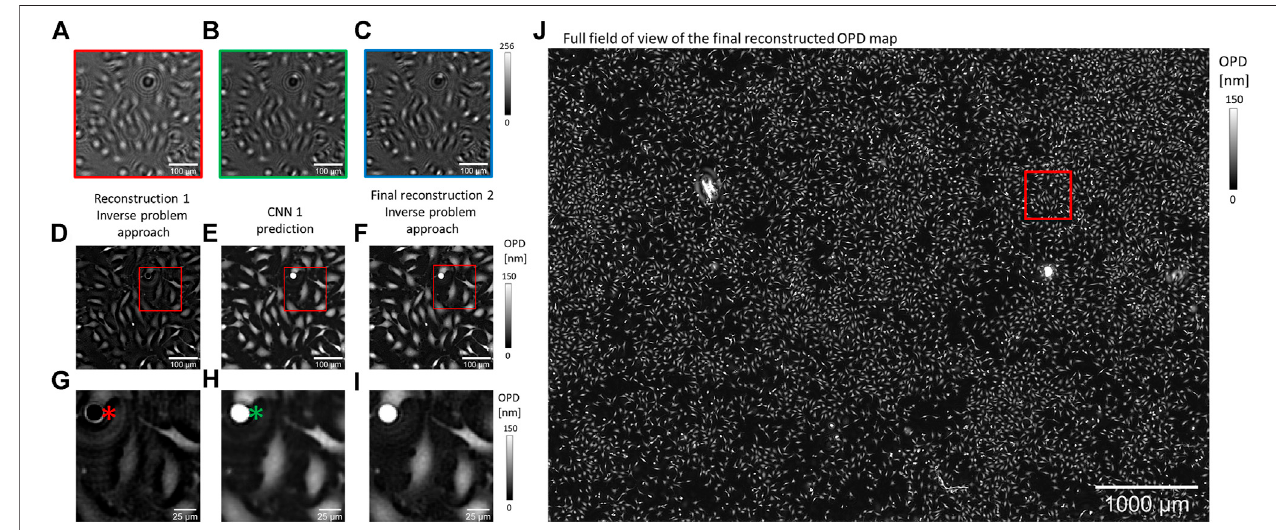
FIGURE 1 | Alternation of deep learning and inverse problem optimization for OPD image reconstruction. (A,B,C) RGB lens-free acquisitions of a fi broblast adherent cell culture.Thesearecroppedimagesofalarge fi eldofviewacquisition(29.4 mm 2 ). (D-I) DetailsofthereconstructedOPDmapatdifferentstepsofthereconstruction(seeredboxin (J) ). (G,H,I) Details of (D,E,F), respectively (see red boxes in (D,E,F) ). (D,G) Reconstructed OPDs after the fi rst reconstruction step were obtained with the inverse problem approach. (E,H) The CNN is applied to perform phase unwrapping and estimate the result of an inverse problem optimization with many iterations. The red asterisk in